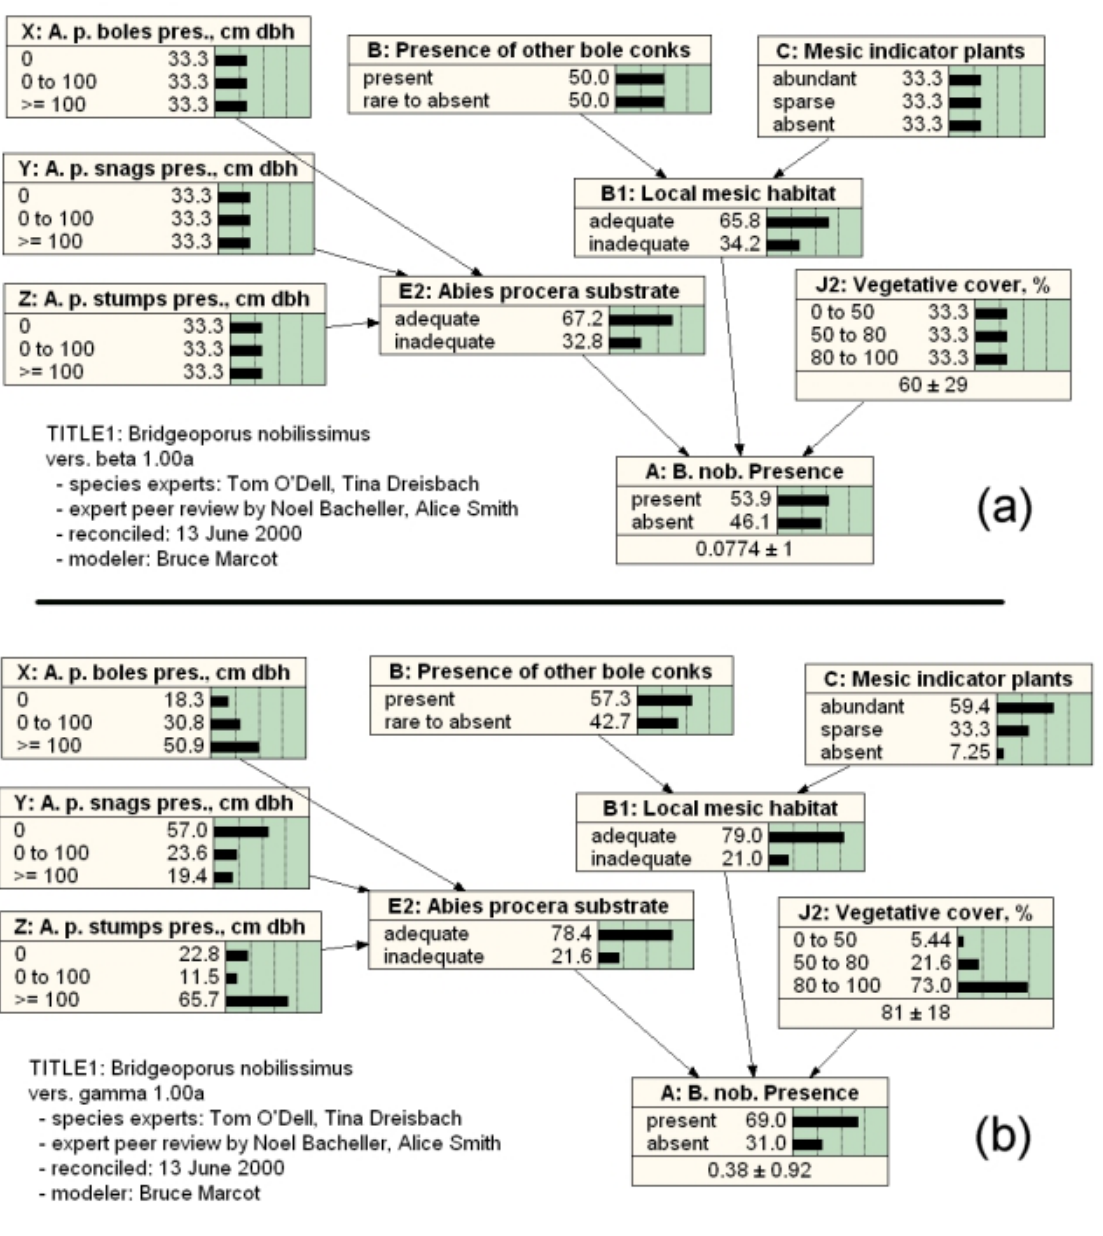
Fig. 3. Two stages (see Fig. 1) in the modeling of a rare fungus using Bayesian belief networks as developed from the influence diagram shown in Fig. 2. (a) beta-level model after peer review, (b) gamma-level model after incorporating known site field data (Table 1). See text for discussion of the initial alpha-level model. No delta-level model is available as further field validation studies had not been